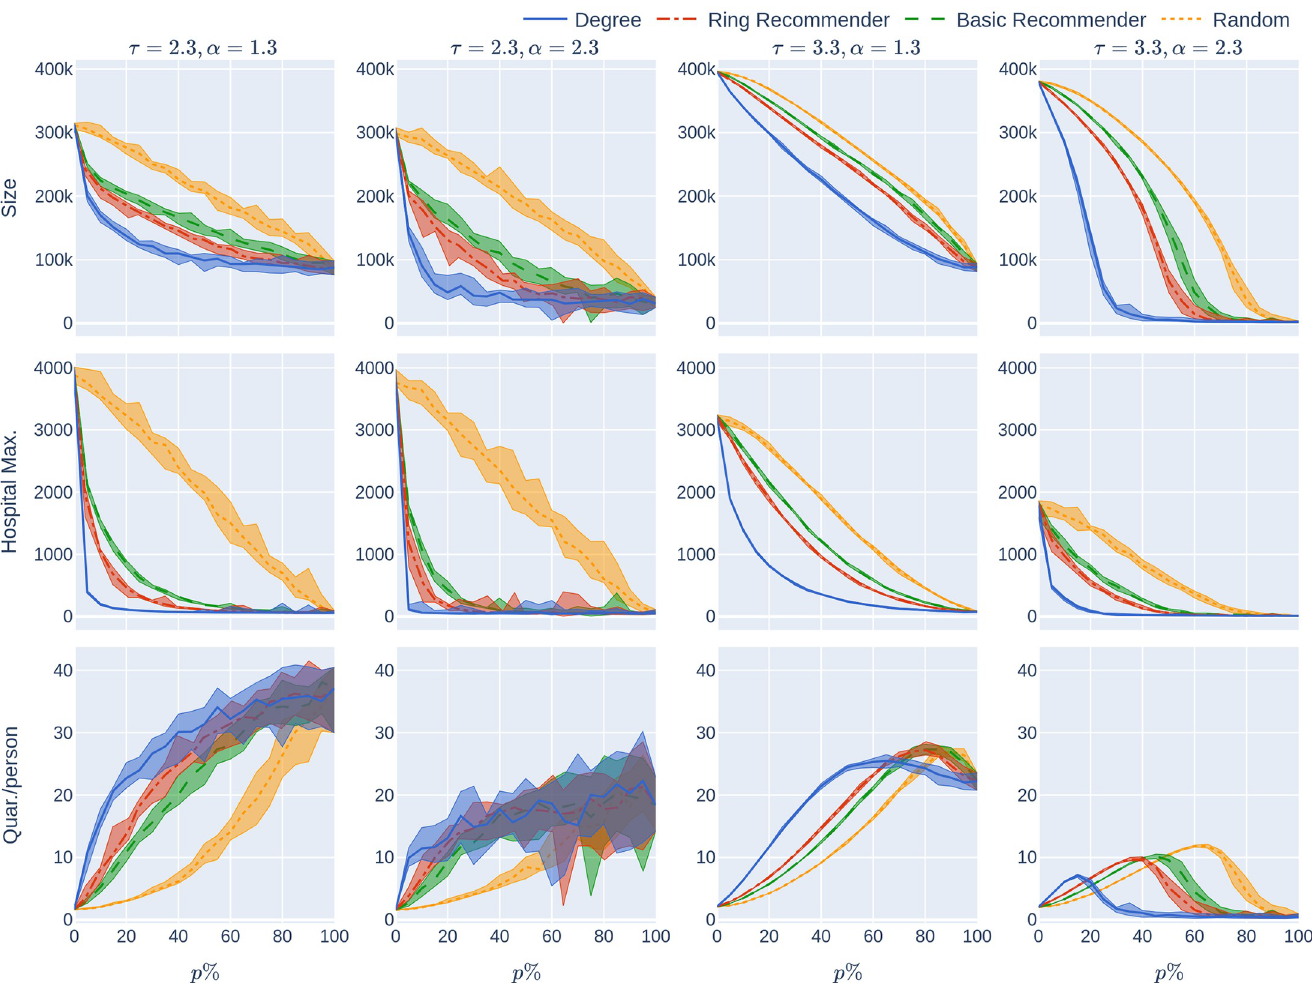
Fig 2. The KPIs (Size, HMax, Quar) as a function of the CTA-uptake percentage p % for the four CTA-uptake scenarios can be found in the rows. The population is modelled using four 500,000 node GIRG networks where τ = 2.3 has more super-spreaders and τ = 3.3 has fewer super-spreaders, α = 1.3 is less geometric and α = 2.3 is more geometric, arranged in the four columns. The x -axis shows the uptake percentage p % varying from 0 to 100% at step size 5%. Simulations are done for the 21 values of p % corresponding to these steps. The y -axis shows the corresponding value of the KPI. The four uptake scenarios correspond to the four curves on each figure. For each parameter value, the plotted result is the median over 10 runs. The shaded region around the plot covers the results of all 10 simulations. The epidemic is started by infecting 100 individuals, chosen uniformly at random. Simulation is halted when there are no more exposed or infected vertices. For completeness (the reader does not need to know this at this point, but it will be useful for comparison later) the simulations use β = 0.05 and q = 0.6. β is the rate of infection. It is defined in Section 2, and this value corresponds to a low rate of infection, for example due to social distancing measures. The parameter q denotes the severity of the quarantine measures. It is studied later, in Experiment